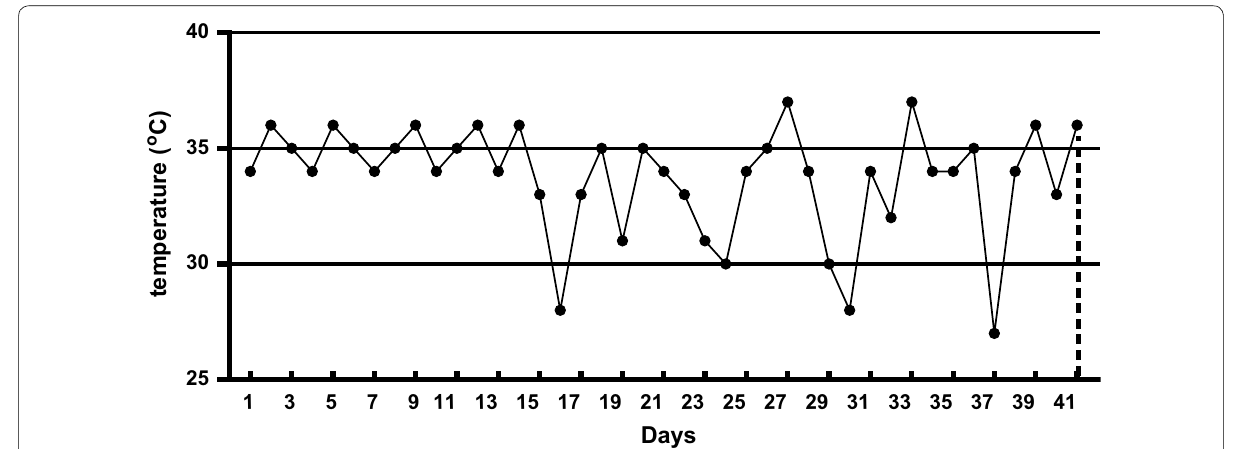
Fig. 1 Average daily temperature during summer season from 12:00 am to 8:00 pm for 42 days of